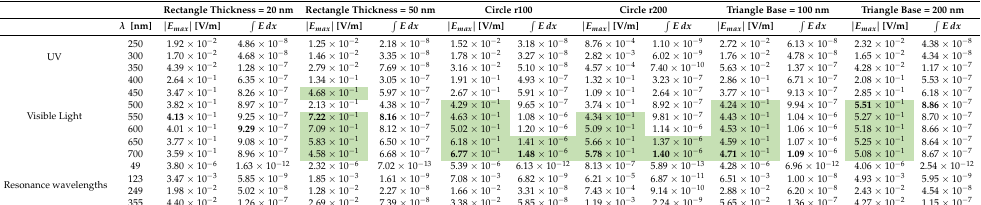
Table A1. Summary table of the results obtained for the silver nanostructures—Probe 1.